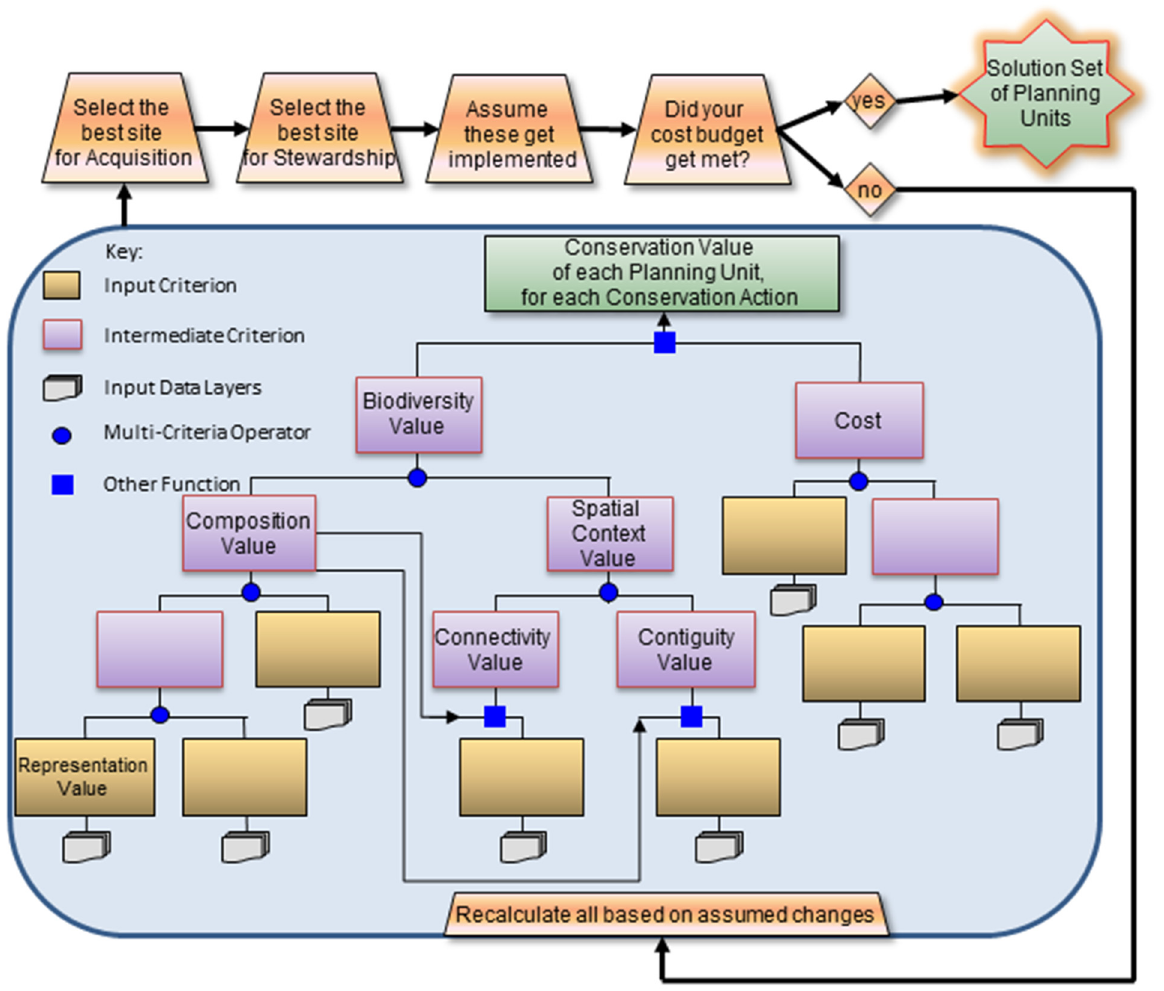
Figure 9. Simplified summary of the Earthwise SDSS for the Little Karoo, South Africa. Blank boxes represent one or many input criteria or intermediate criteria in the MCDA. Once sites are assumed to be conserved, the marginal value functions (MVFs) of the affected elements will produce new representation results, and connectivity and other spatial context values will change as well, yielding new top planning units. Note: The Little Karoo SDSS has additional useful nuances not represented in this simplified diagram, especially power-weighted division by cost, and net biodiversity value of an action (see Supplementary Materials S1: User Guide).